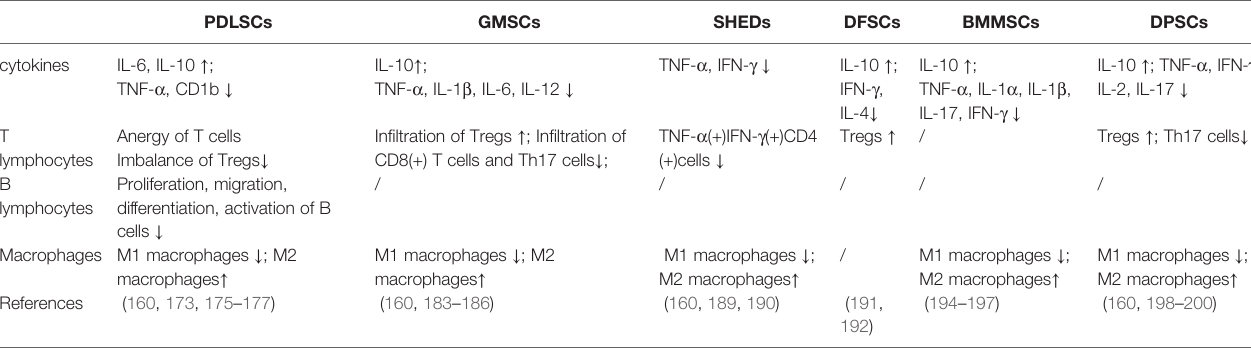
TABLE 3 | Role of MSCs in anti-in fl ammation. PDLSCs